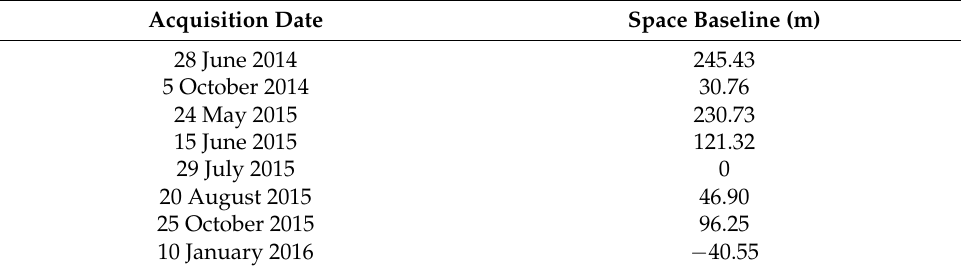
Table 2. Baseline information of eight TerraSAR images.